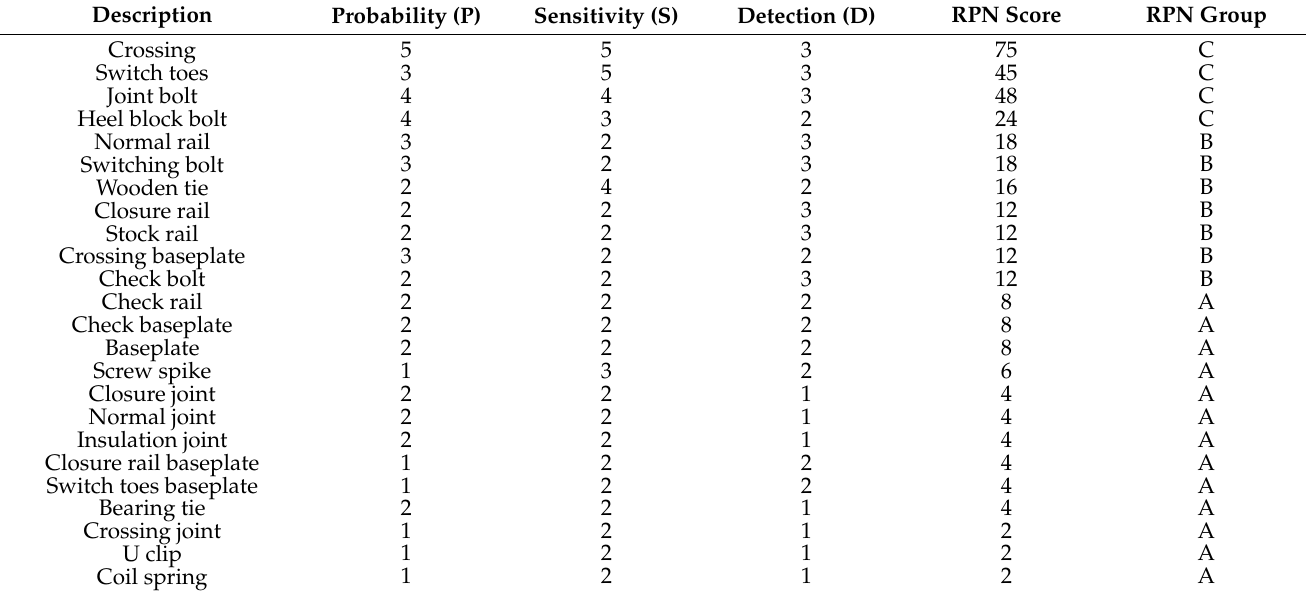
Table 9. Overview of RPN groups based on the types of turnout